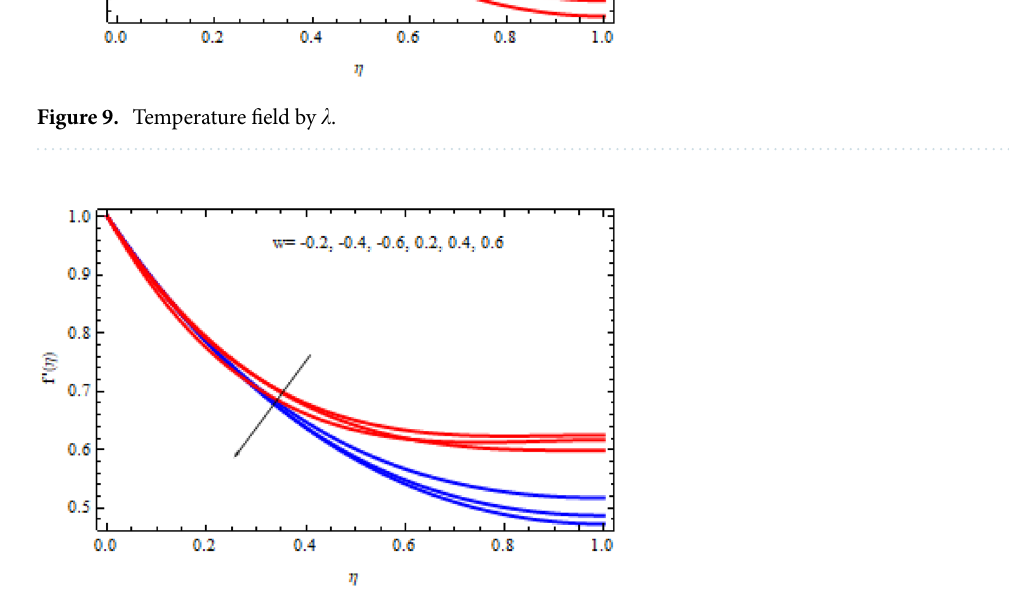
Figure 10. Velocity field by